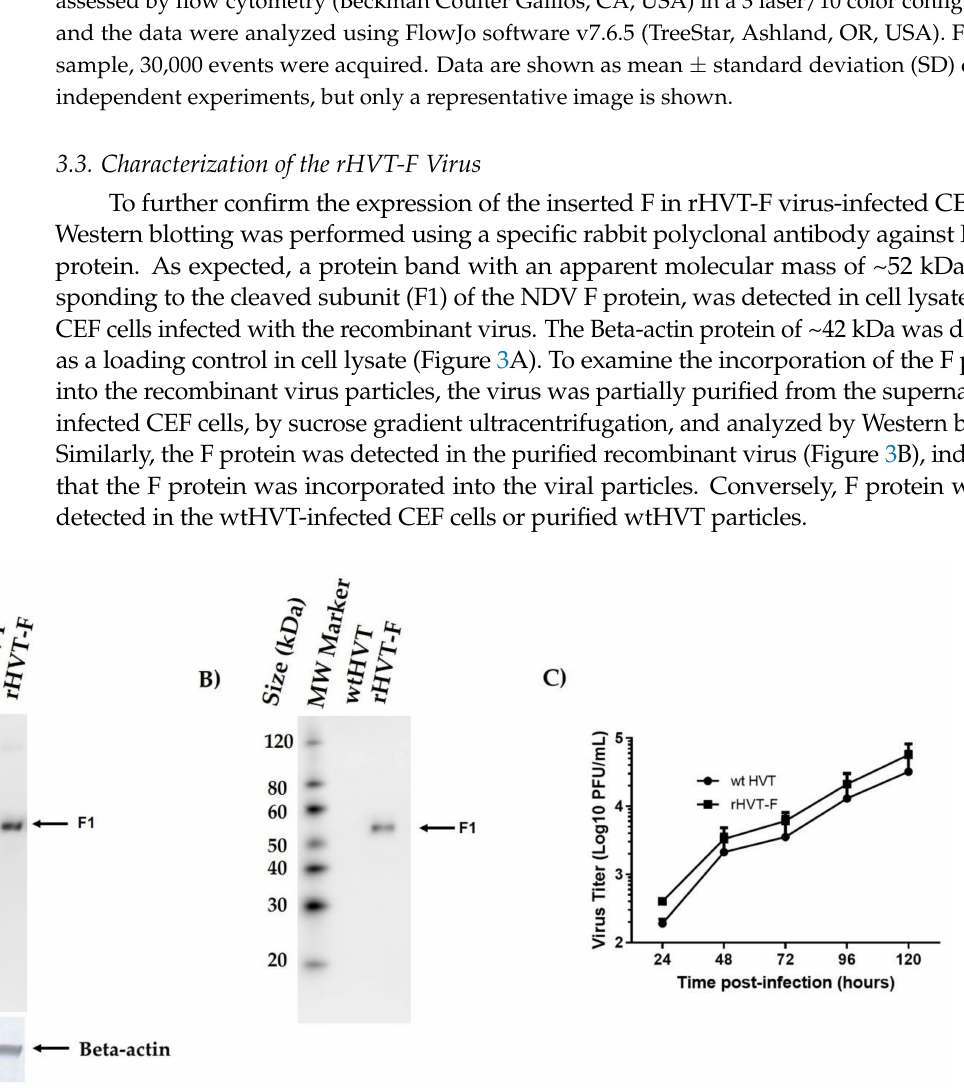
Figure 3. Characterization of the rHVT-F. Expression of the NDV F protein in CEF cells and their incorporation into rHVT-F virus particles. CEF cells were infected with the recombinant virus at an MOI of 0.01. Then, the CEF cells were harvested at 72 hpi and processed to prepare cell lysates. Additionally, viruses from the supernatants of CEF cells infected with the recombinant virus were concentrated using tangential filtration on Sartoflow Advanced and subjected to ultracentrifugation on sucrose gradients to obtain partially purified virus particles. These samples were evaluated by Western blot analysis using a specific rabbit polyclonal antibody, against the NDV F protein, as primary antibody and a mouse anti-rabbit IgG antibody, conjugated to horseradish peroxidase (HRP), as a secondary antibody. ( A ) From the left to the right are molecular weight (MW) markers (lane 1), cell lysates from wtHVT-infected CEF cells (lane 2), and rHVT-F-infected CEF cells (lane 3). The Beta-actin protein (~42 kDa) was used as a loading control in cell lysate. ( B ) From the left to the right are MW markers (lane 1), partially purified virus particles from the supernatant: of wtHVT-infected CEF cells (lane 2), and rHVT-F-infected CEF cells (lane 3). The black arrow indicates a ~52 kDa band corresponding to the cleaved subunit (F1) of the NDV F protein. ( C ) In vitro replication kinetics